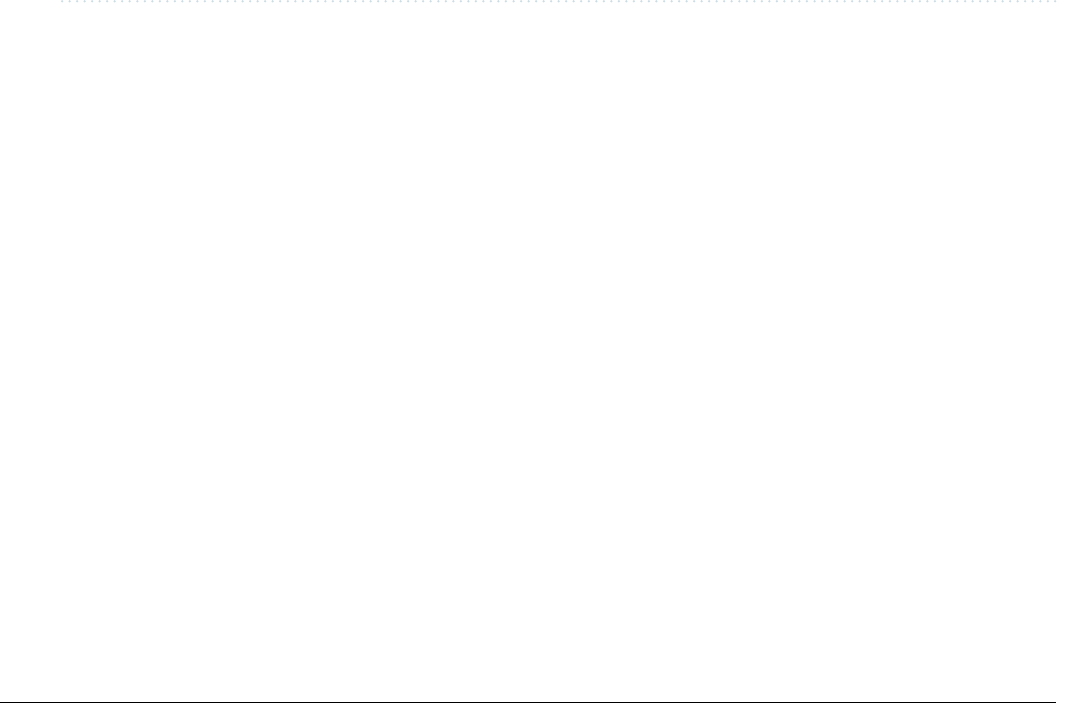
Figure 26. Forced dissipative 2DOF system observations for γ = 0.9